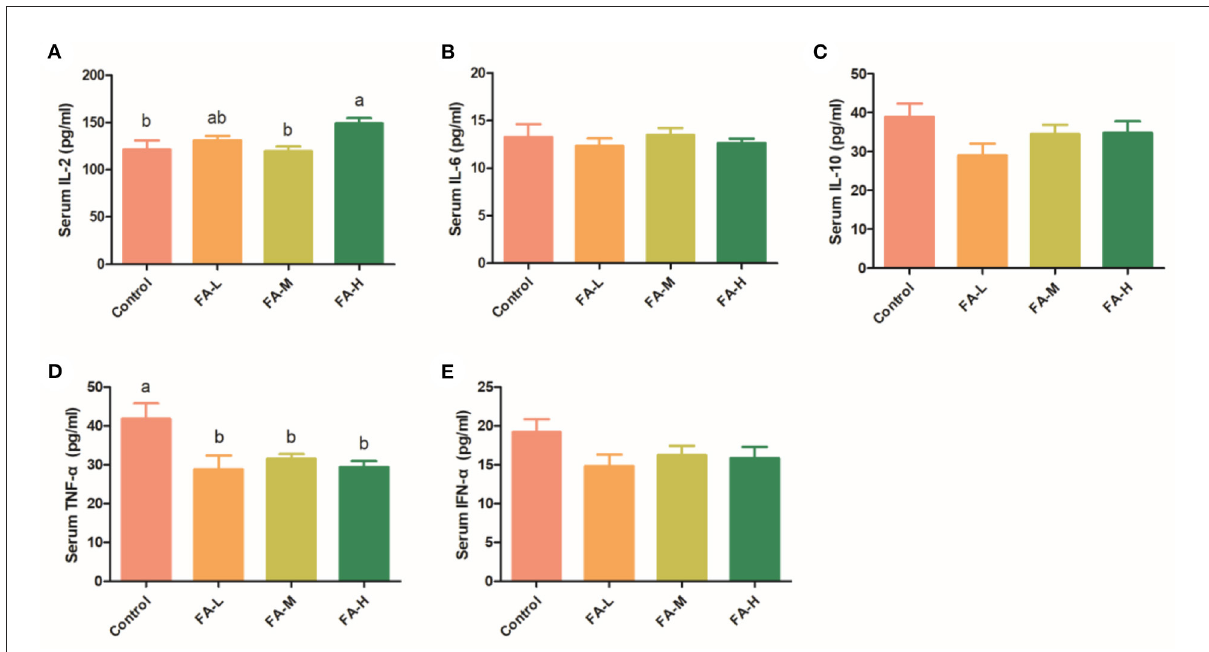
FIGURE1 Effect of FA on serum concentration of IL-2 (A) , IL-6 (B) , IL-10 (C) , TNF- α (D) , and IFN- α (E) . Data with different superscript letters are significantly different ( P < 0.05).